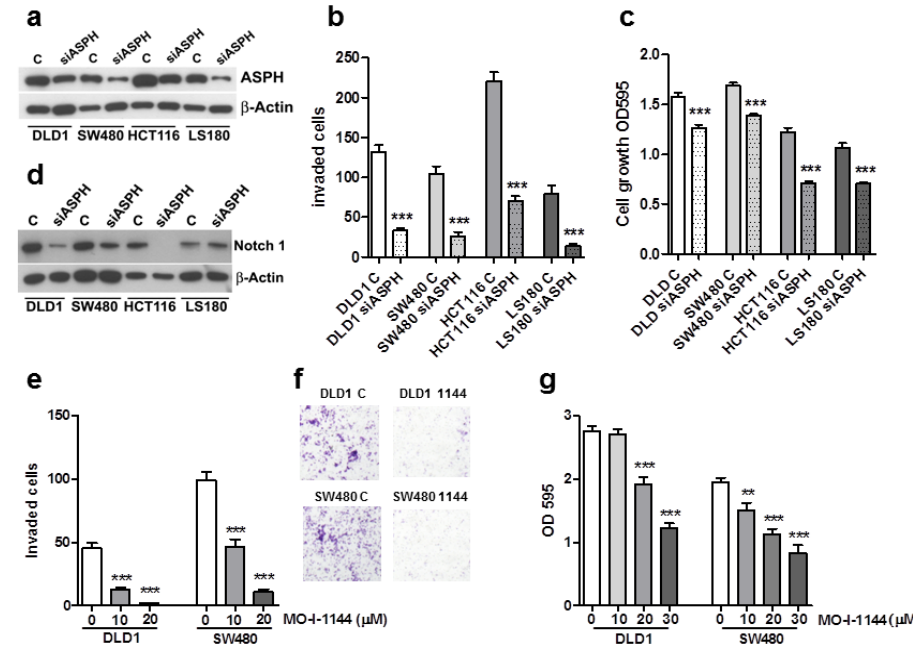
Figure 4. ASPH silencing or activity inhibition decreases cell invasion and proliferation in a panel of CRC cell lines. Specific ASPH siRNAs visibly downregulate ASPH expression after 18 hours ( a ). Concomitantly, cell invasion ( b ) and proliferation ( c ) are significantly inhibited. All these effects are associated with Notch1 inhibition ( d ). One representative experiment out of three is reported. β -Actin was utilized as a loading control. Means ± SEM are reported. *** p < 0.001. DLD1 and SW480 cell lines were exposed to increasing concentration of MO-I-1144. For the invasion test ( e ), filters were recovered and counted after 18 h. Representative images of filters from 20 µ M treated cells are shown in ( f ). Cell growth was evaluated after 96 h by the crystal violet assay ( g ). One representative experiment (conducted on 10 replicates) out of three is reported. Mean ± SEM are reported. ** p < 0.01, *** p <